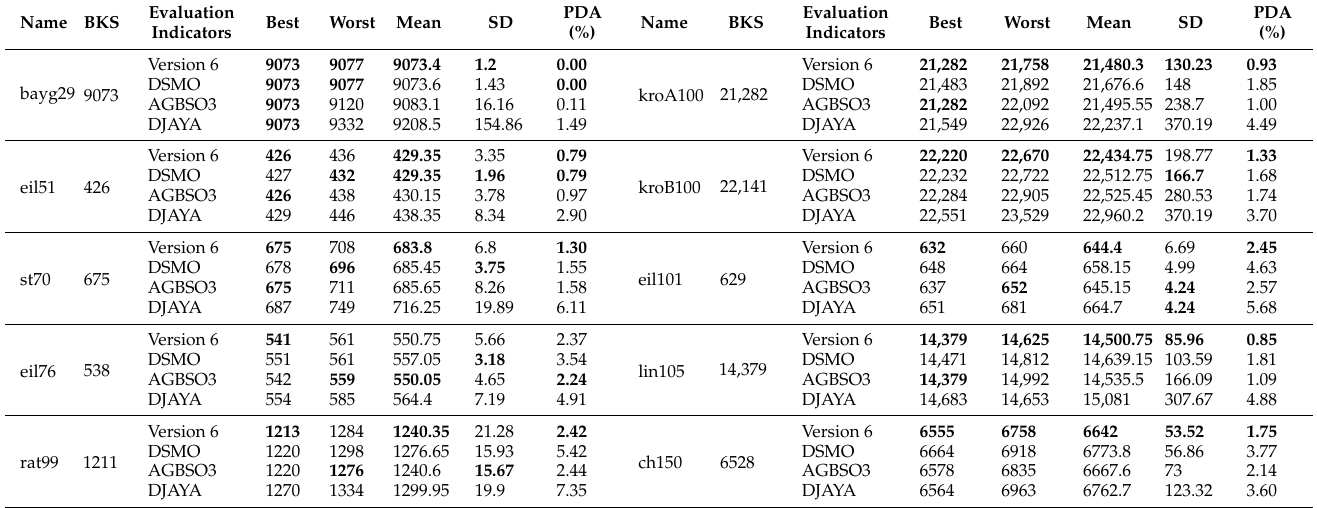
Table 11. Comparison results of Version 6 and the other algorithms without a local search algorithm.